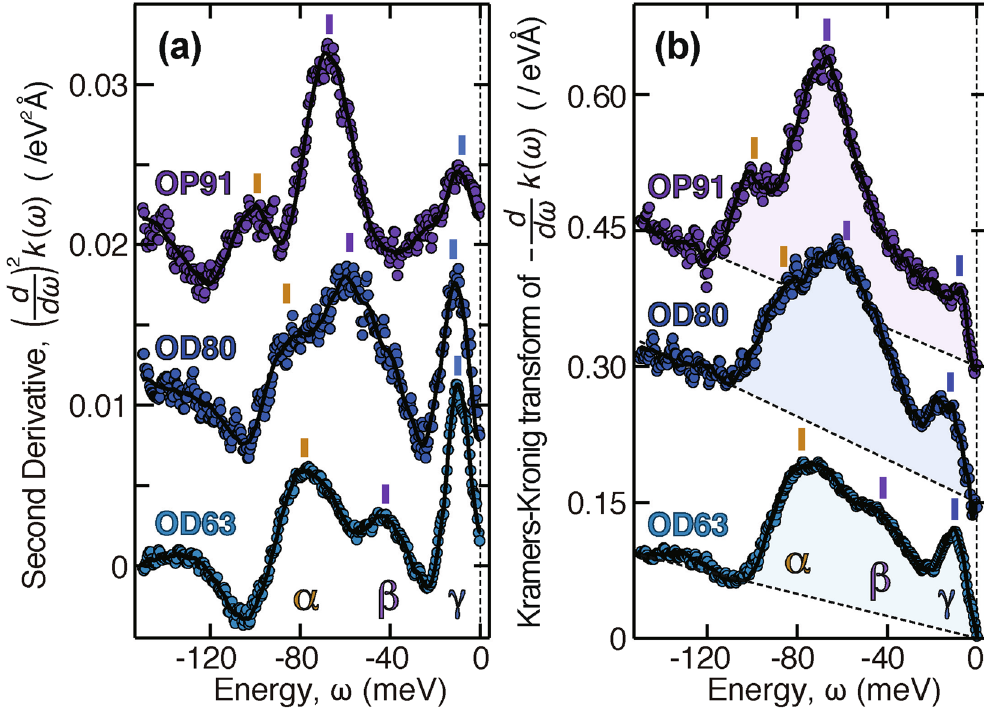
Figure 4. Doping dependence of nodal data. ( a ) Second energy derivatives of dispersion, ( d / d ω ) 2 k ( ω ), offset from each other by 0.01 eV − 2 Å − 1 . ( b ) Kramers-Kronig transform of inverse group velocity, ( d / d ω ) k ( ω ), offset from each other by 0.15 eV − 1 Å − 1 . The original data taken with h ν = 8.1 eV for optimally doped T c = 91 K (OP91) and overdoped T c = 80 K (OD80) samples were reported in ref. 18.